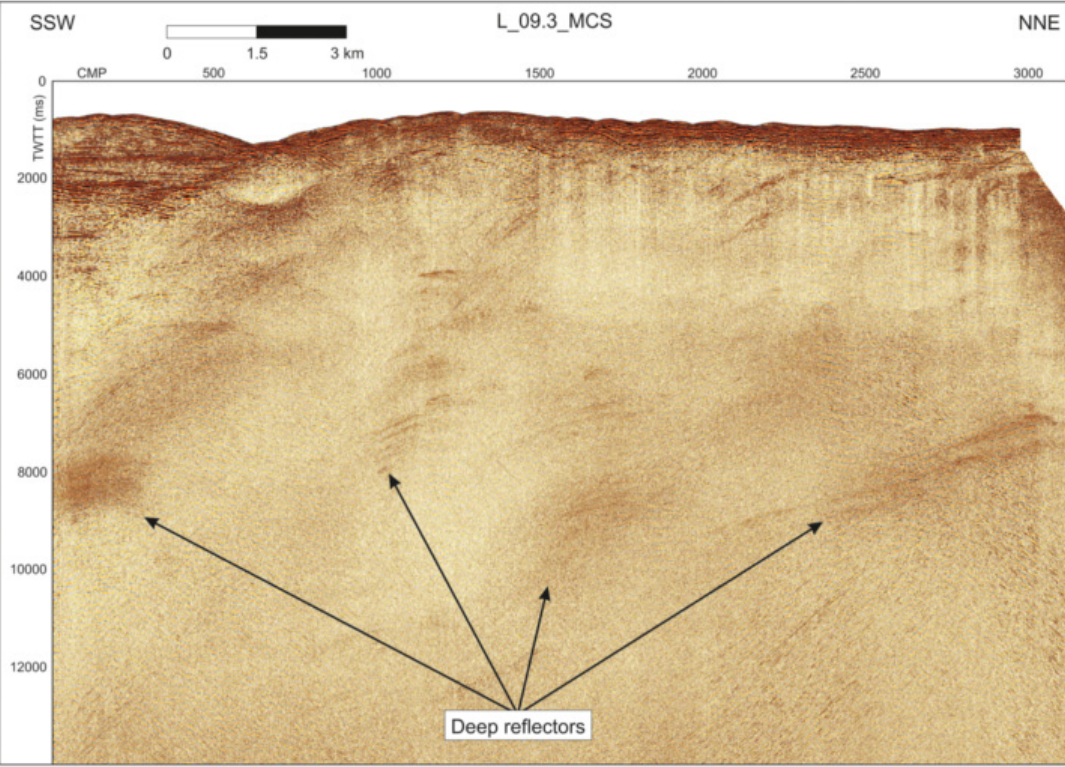
Figure 17. Unmigrated stack of the L_09.3_MCS line (Ionian Sea, see Figure 2 for line location). See text for further